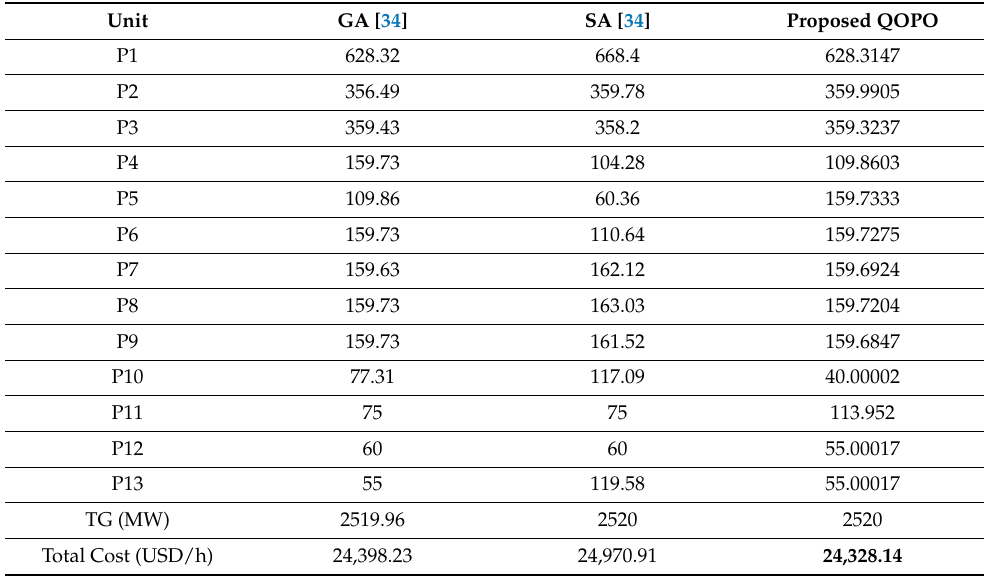
Table 5. Comparison of power distribution among 13 units for the load demand of 2520 MW.